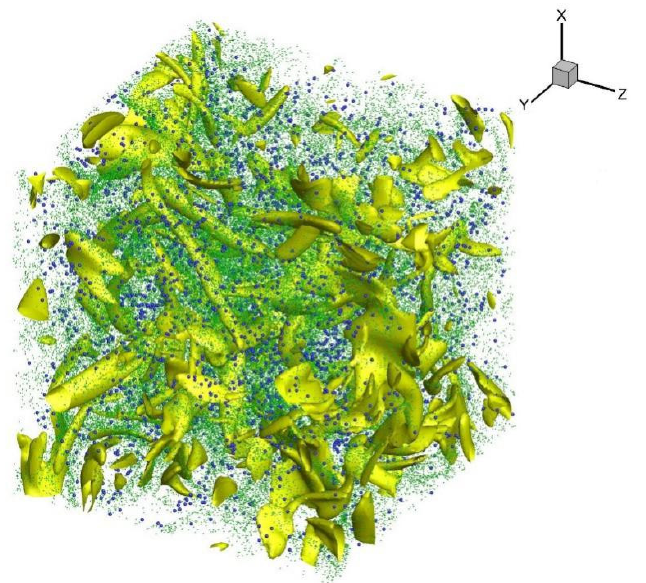
Figure 1. Particles (green dots) and bubbles (blue dots) in a homogeneous isotropic turbulence characterized by 3D vorticity field [40].